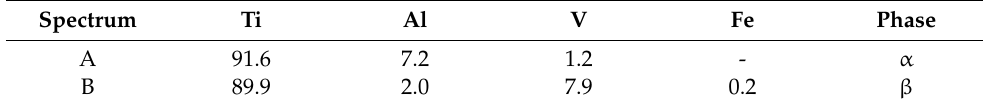
Figure 5. SEM micrographs of the 0 ◦ XY -sample ( a , b ) after 704 ◦ C/120 (cid:48) and 90 ◦ Z -sample ( c , d ) after 740 ◦ C/130 (cid:48) . All images were acquired on the plane perpendicular to the build platform. Panel ( b ) illustrates the magnification (40 k × ) of the red square area in panel ( a ) (2 k × ), while panel ( d ) shows the magnification (40 k × ) of the yellow square area in panel ( c ) (2 k × ). Orange, green and light-blue dotted lines indicate primary, secondary and tertiary α -laths. Table 3. Chemical composition (EDS) of spectra A and B in